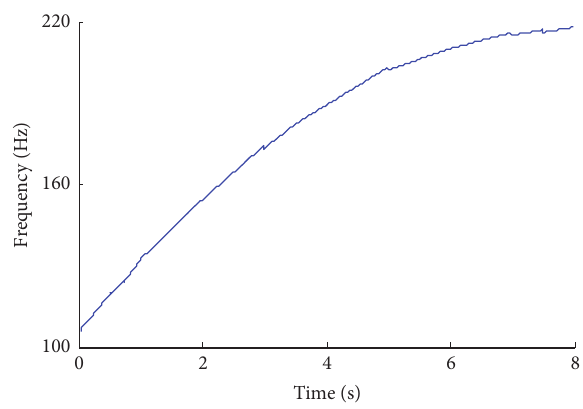
Figure 7: The IF extracted by the MSCPP method.